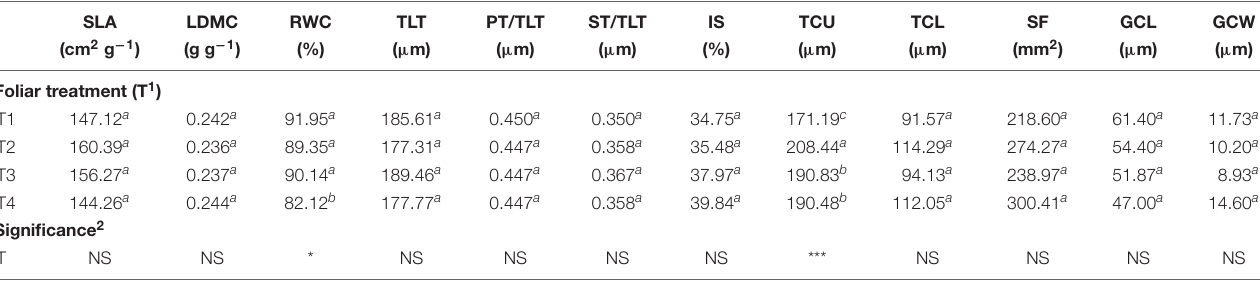
TABLE 4 | Main effects of foliar treatments on functional anatomical traits in leaves of V. vinifera “Aglianico” vines. Different letters within column indicate significant differences according to Duncan’s multiple-range test ( P ≤ 0.05). SLA